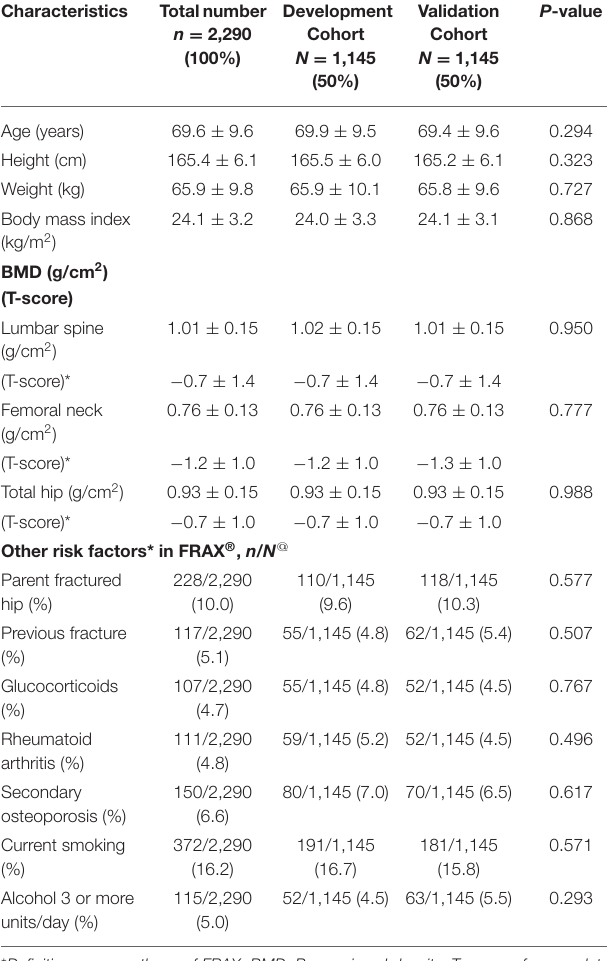
TABLE 1 | The demographic characteristics of all the participants.